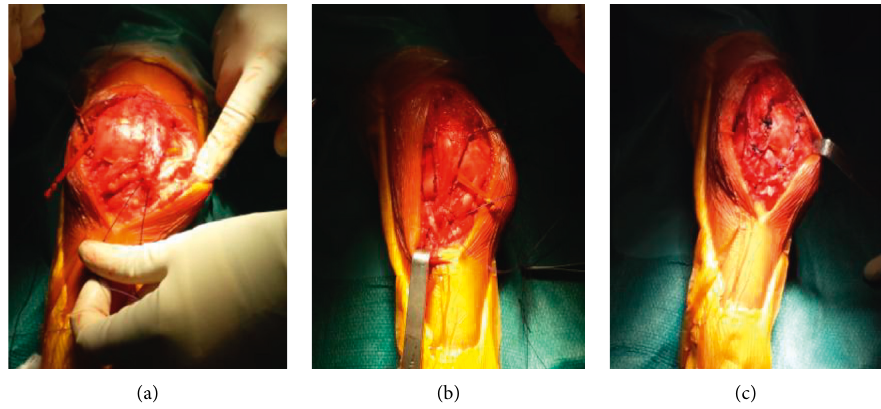
Figure 3: Peroperative pictures: after LLR and MPFL tenoplasty with allograft (a); a portion of vastus medialis was individualised and translocated to the lateral aspect of the patella (Krogius tenoplasty) (b); final sutures